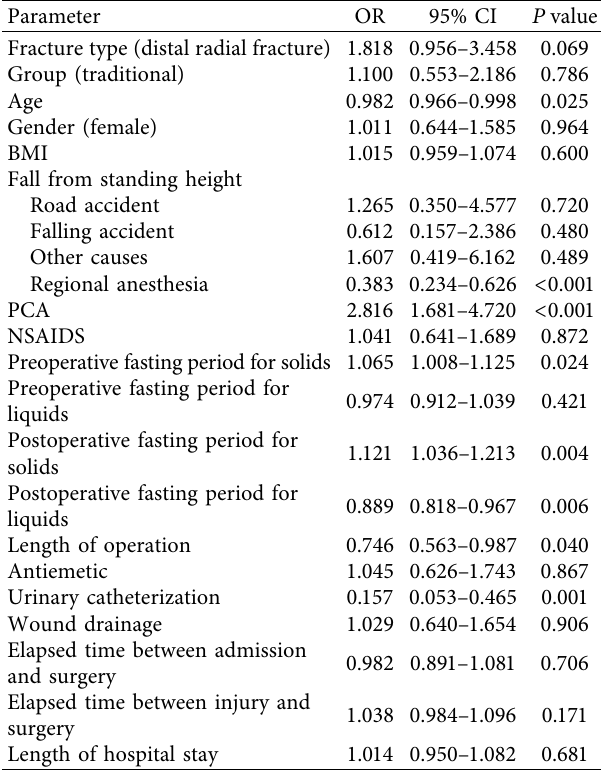
Table 5: Results of multiple logistic regression analysis using patient demographic, injury, and perioperative management characteristics to predict the satisfaction level of the patients on